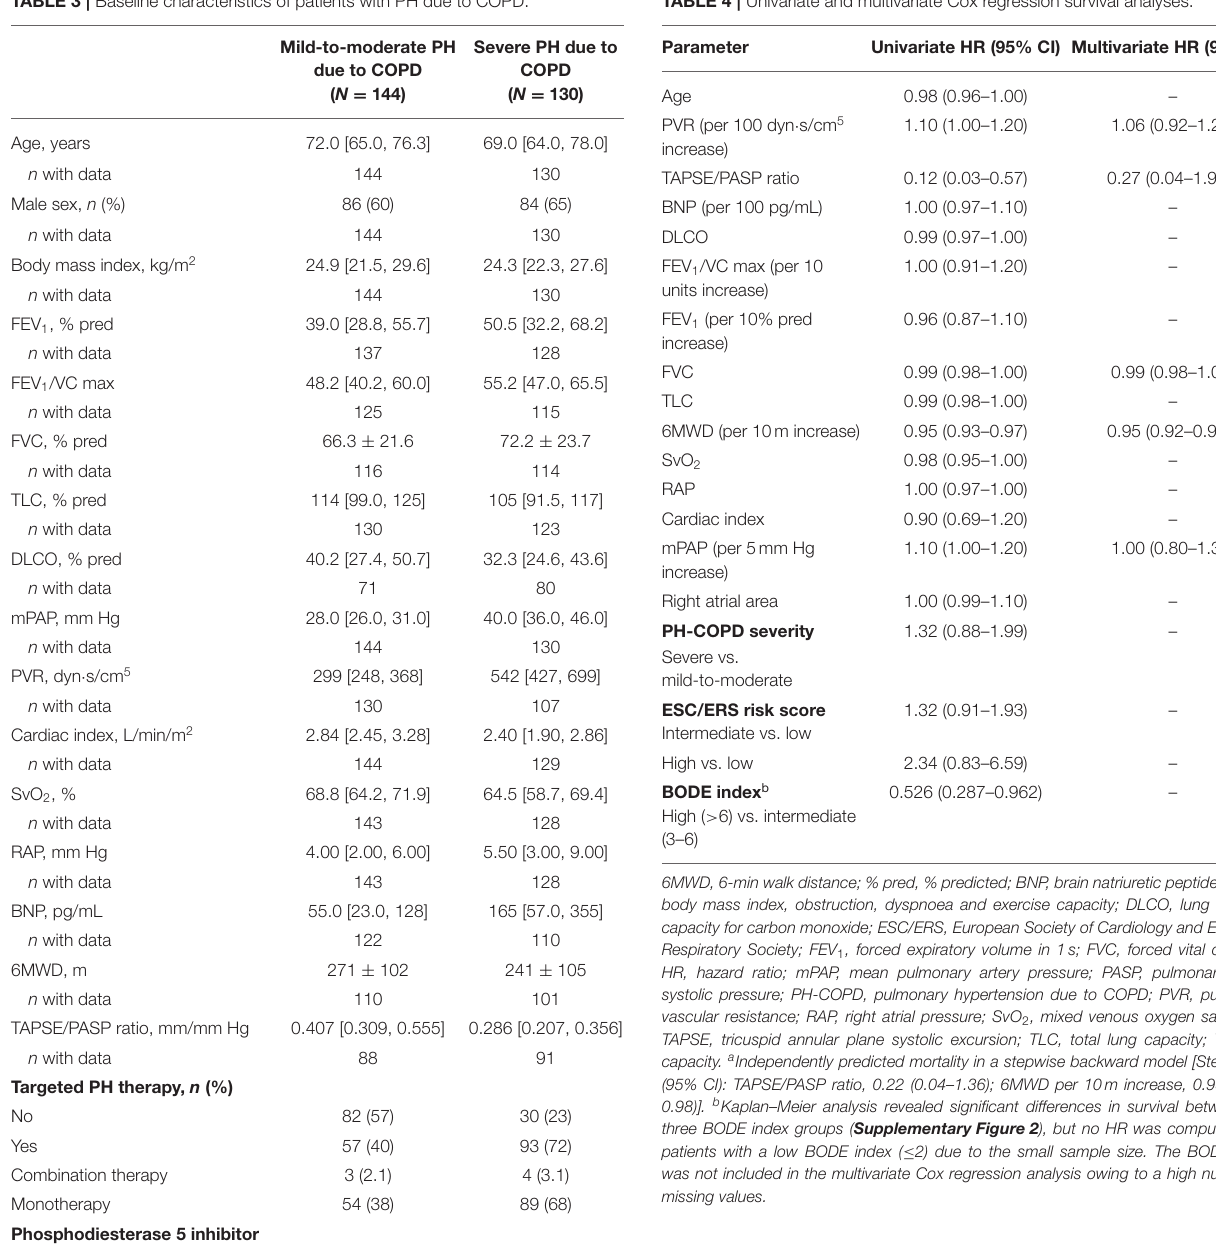
TABLE 3 | Baseline characteristics of patients with PH due to COPD. TABLE 4 | Univariate and multivariate Cox regression survival